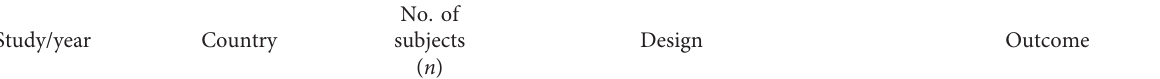
Table 1: Summary of clinical studies on the FF single